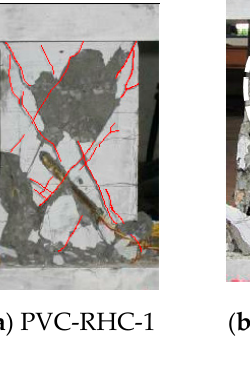
Figure 6. Failure pattern of specimens.